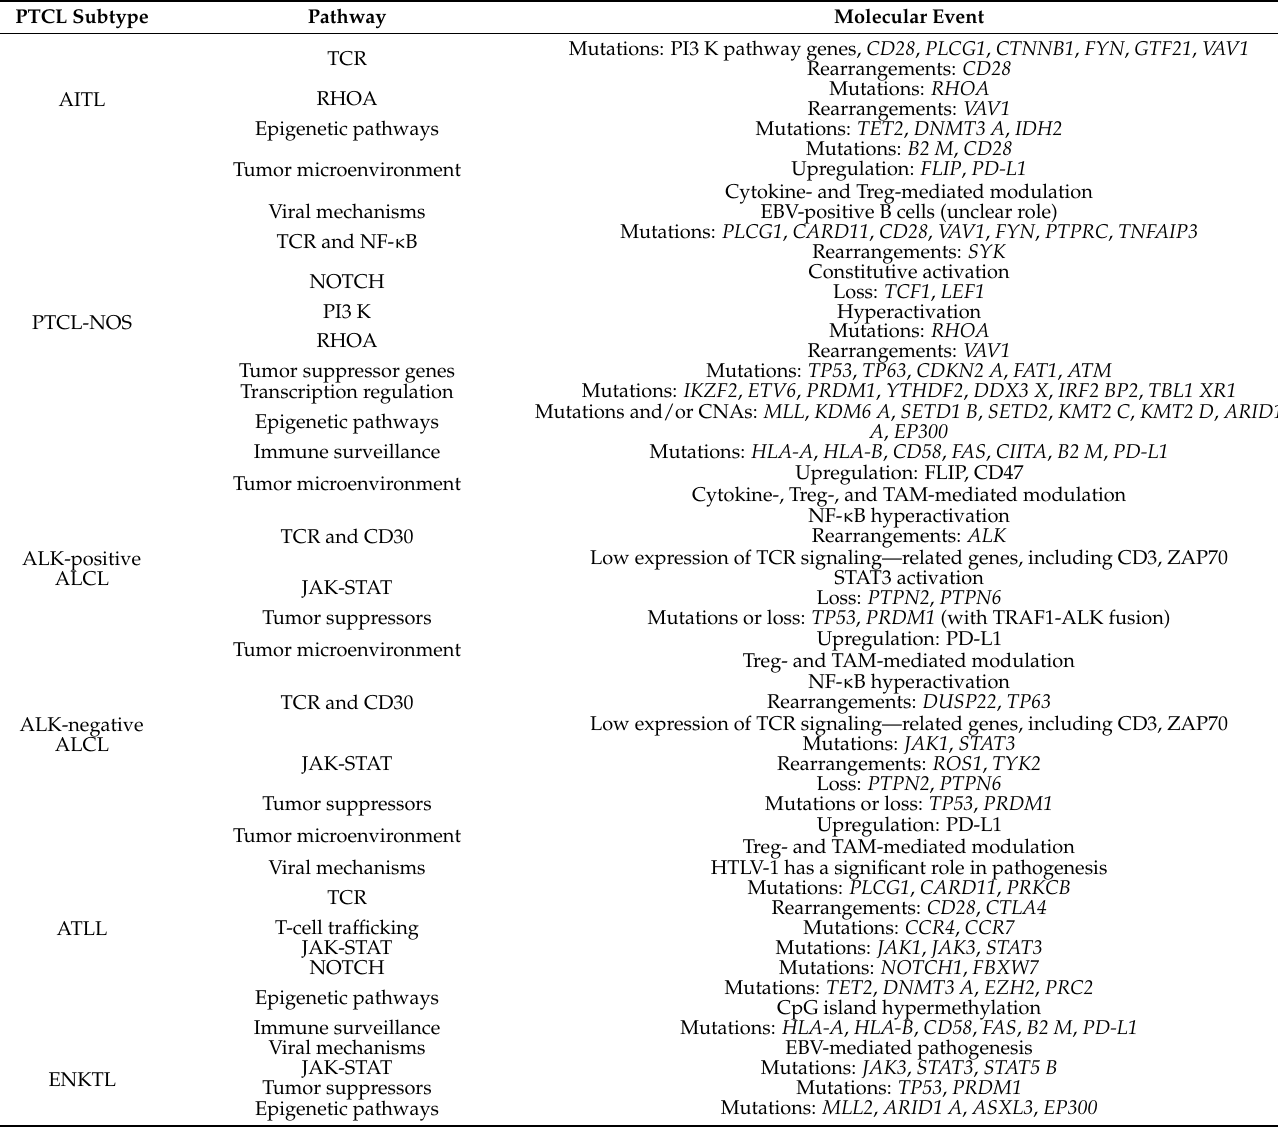
Table 1. Common pathogenic mechanisms associated with peripheral T-cell lymphoma (PTCL)